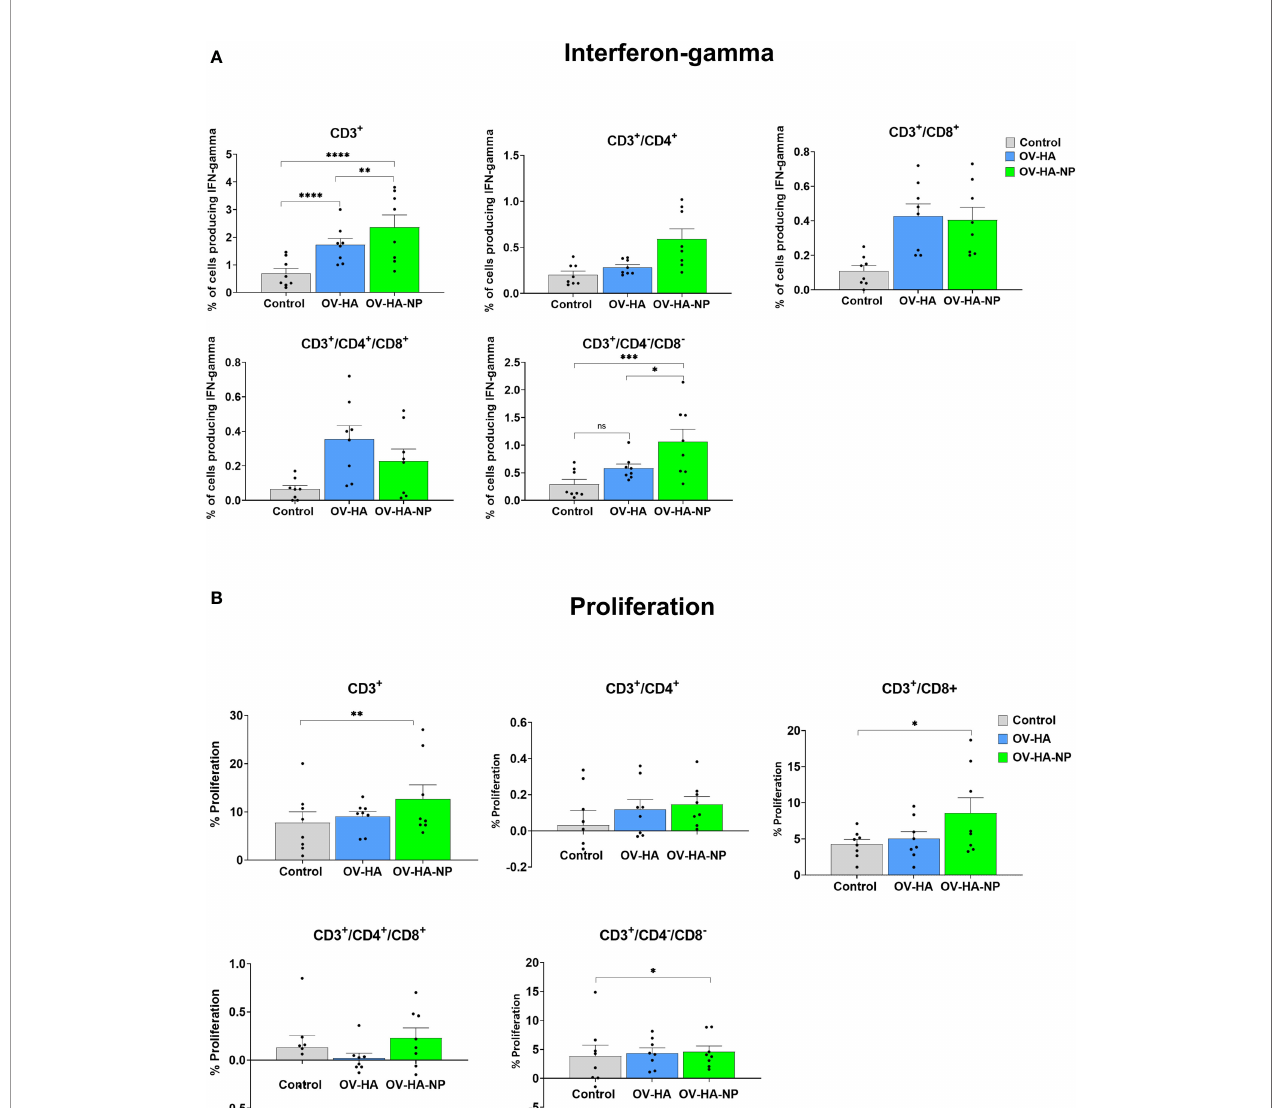
FIGURE 5 | T-cell immune response to immunization. PBMCs isolated from pigs at 35 dpi following recall stimulation with inactivated IAV-S were analyzed for: (A) IFN- g production by different T-cell subsets measured by fl ow cytometry assay; and (B) T-cells proliferation by CFSE dilution assay. Data represents group means and error bars represent SEM. P-values: *P < 0.05, **P < 0.01, ***P < 0.001, ****P < 0.0001; ns, non-signi fi